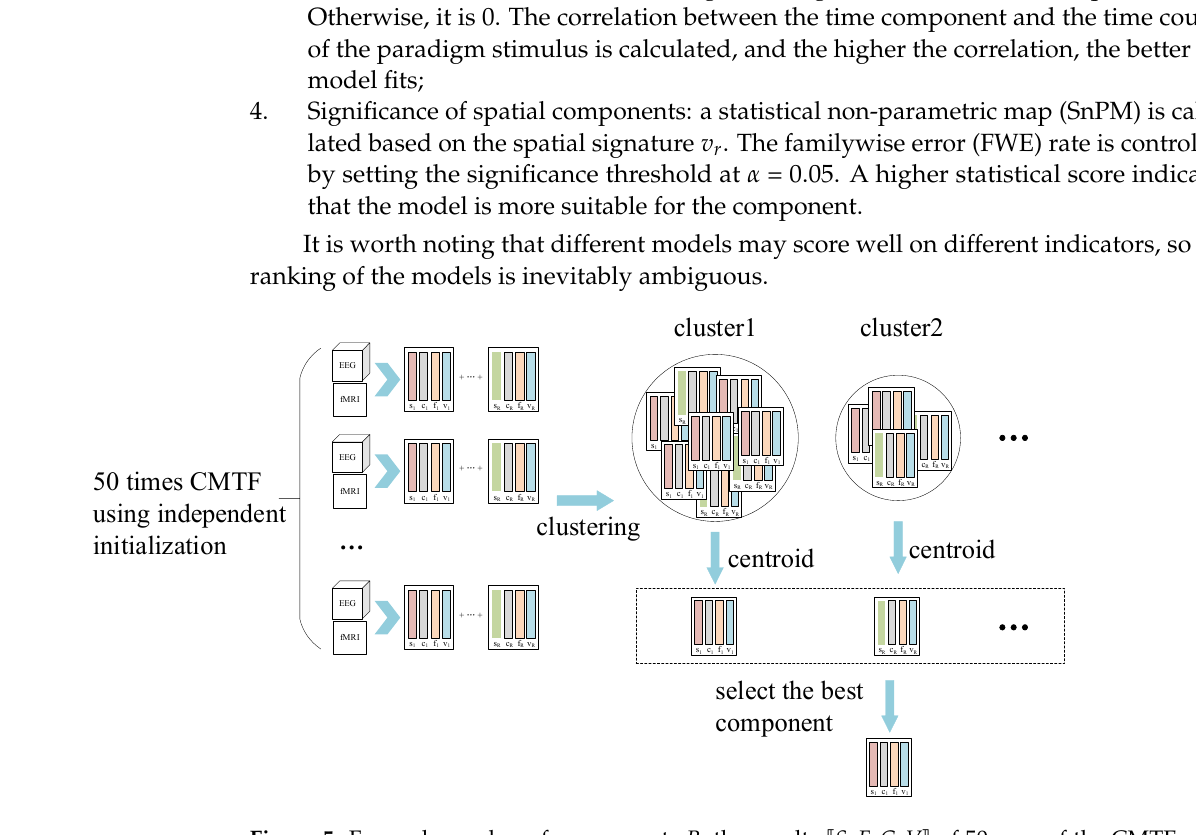
Figure 5. For each number of components 𝑅 , the results ⟦𝑆 , 𝐹 , 𝐶 , 𝑉⟧ of 50 runs of the CMTF were analyzed using the graph-structured clustering algorithm to obtain multiple component clusters, with the higher cardinality of a cluster being the more stable and plausible. The central clustering component of the component cluster was used to represent that component cluster, and the component that best represented that component number 𝑅 was selected.